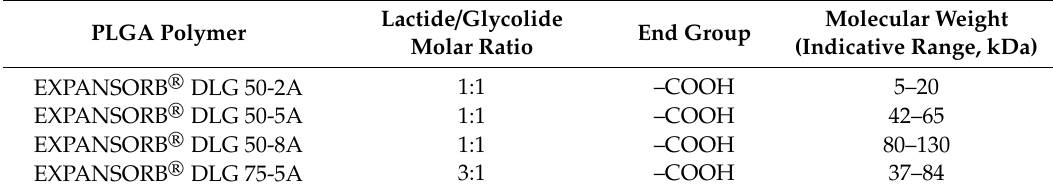
Table 1. Properties of the utilized PLGA polymers.